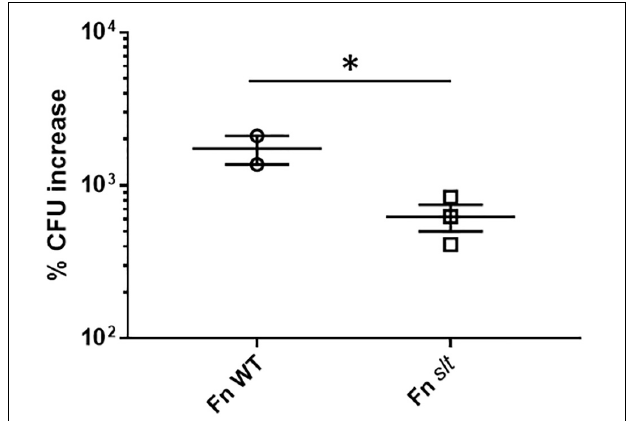
FIGURE 6 | Replication of F. novicida in J774.1 murine macrophages. Macrophages were infected with WT or slt strains at an MOI of ∼ 100:1 and incubated in the presence of gentamicin to eliminate extracellular bacteria. At 4 and 24 h time points, cells were lysed and plated for recovered bacteria, and percent increase of bacteria from 4 to 24 h was calculated. Results from three independent experiments performed in triplicate wells are shown, and statistical significance was determined by student’s t -test; ∗ P < 0.05.